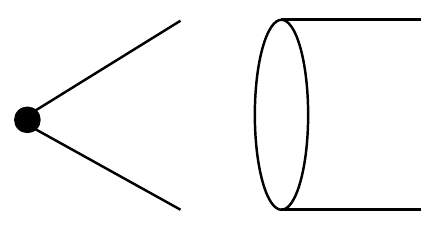
Figure 7 . Radiative corrections to the three point